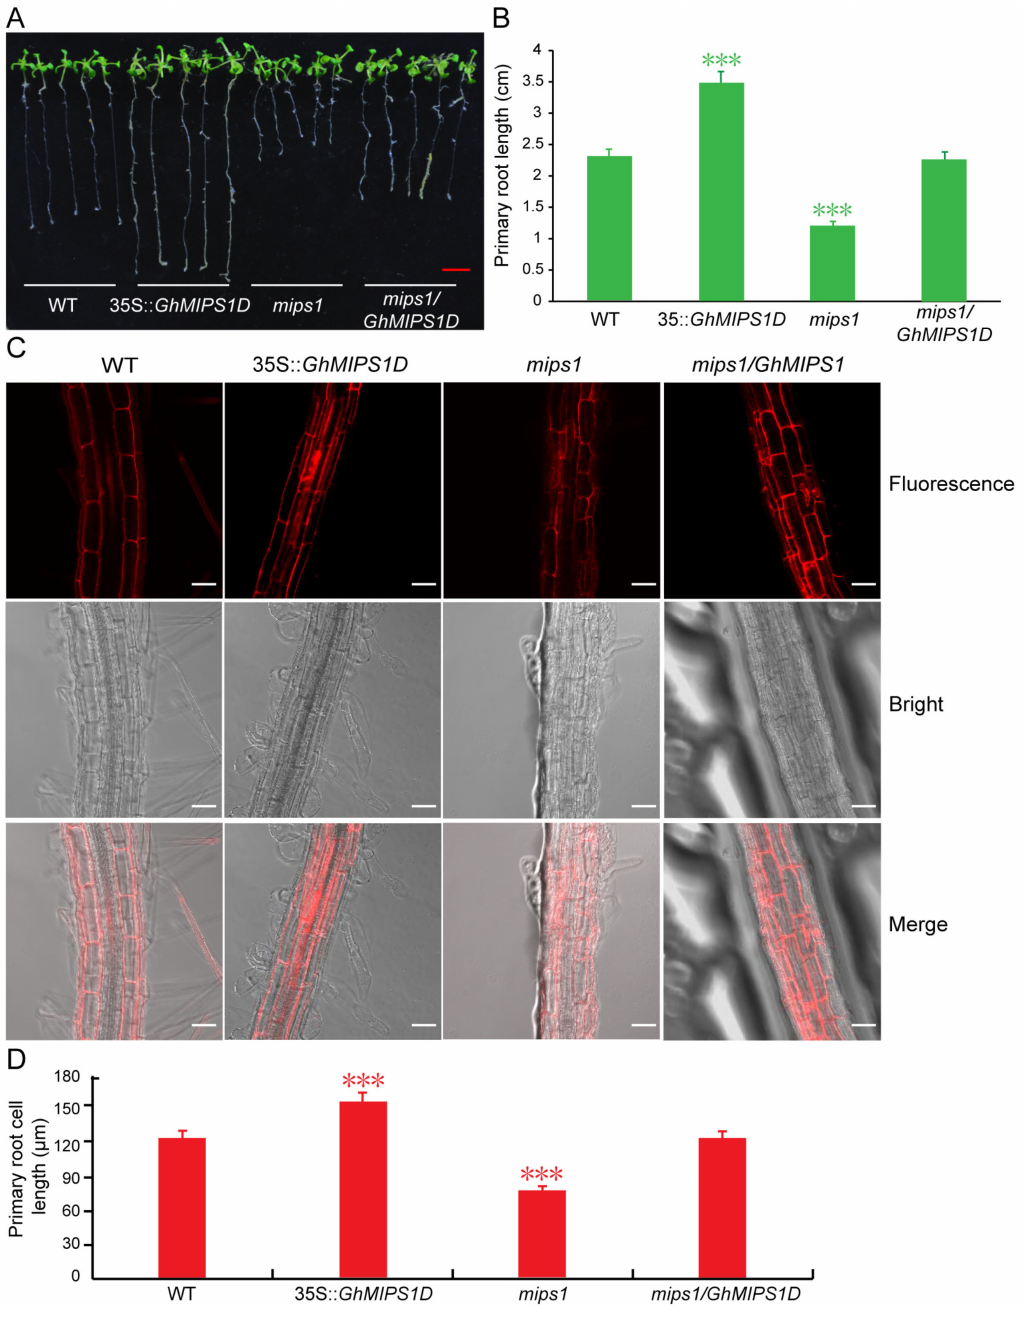
Figure 6. Ectopic expression of GhMIPS1D promotes Arabidopsis root cell elongation. ( A ) The primary root phenotypes of wild-type (WT), transgenic lines ectopically expressing GhMIPS1D ( 35S::GhMIPS1D ), mips1 mutants ( mips1 ) and transgenic lines expressing GhMIPS1D in mips1 mutants ( mips1/35S::GhMIPS1D ). Red bar = 0.5 cm. ( B ) The primary root lengths are measured ( n = 10). ( C ) Fluorescence images of Arabidopsis root cells under confocal microscopy. Bars = 50 µ m. ( D ) The root cell lengths are measured ( n = 50). The results show that ectopic expression of GhMIPS1D significantly induces the cell length in Arabidopsis roots. ***, p < 0.001 compared to